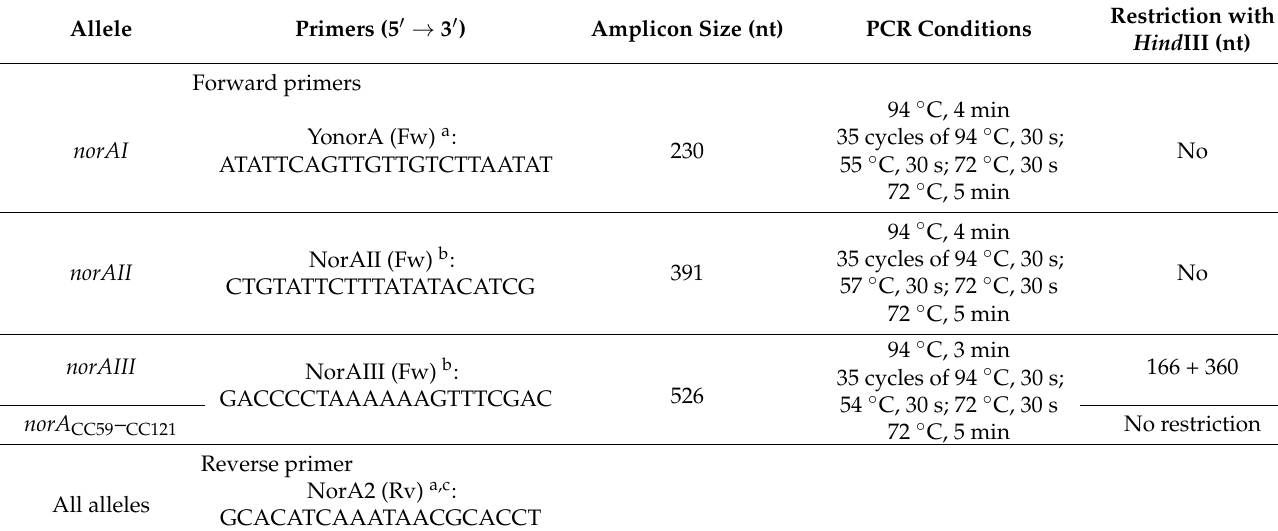
Table 1. Molecular approach used for differentiation of norA